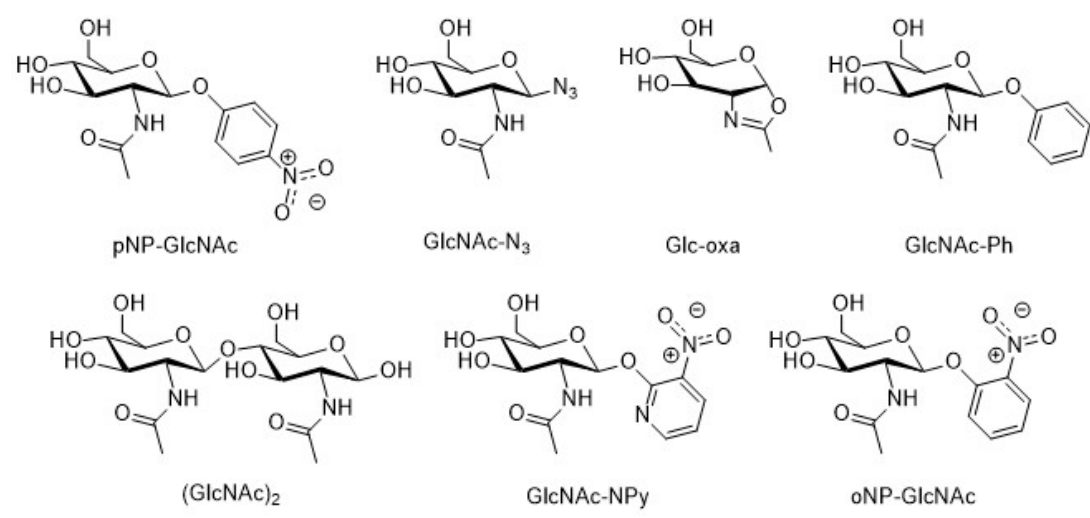
Figure 3. GlcNAc donor substrates used in GH20-catalyzed trans-glycosylation reactions.